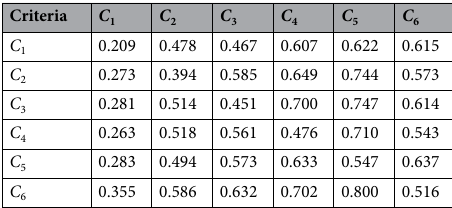
Table 3. The total influence matrix T .